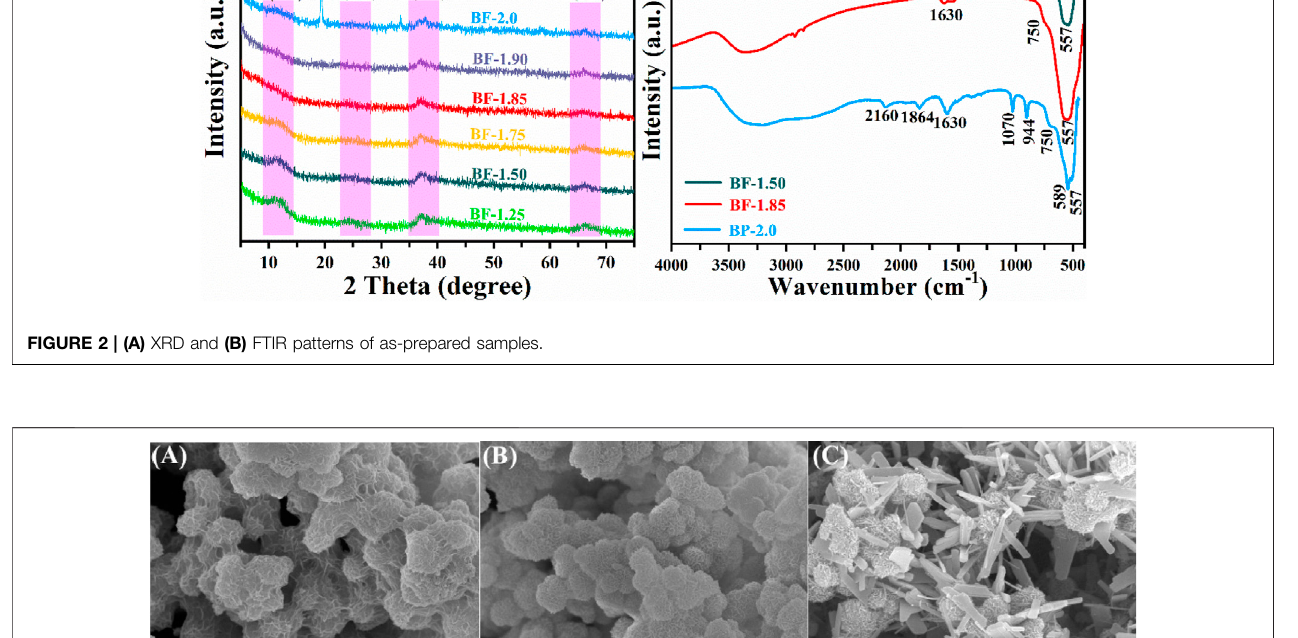
Frontiers in Chemistry |